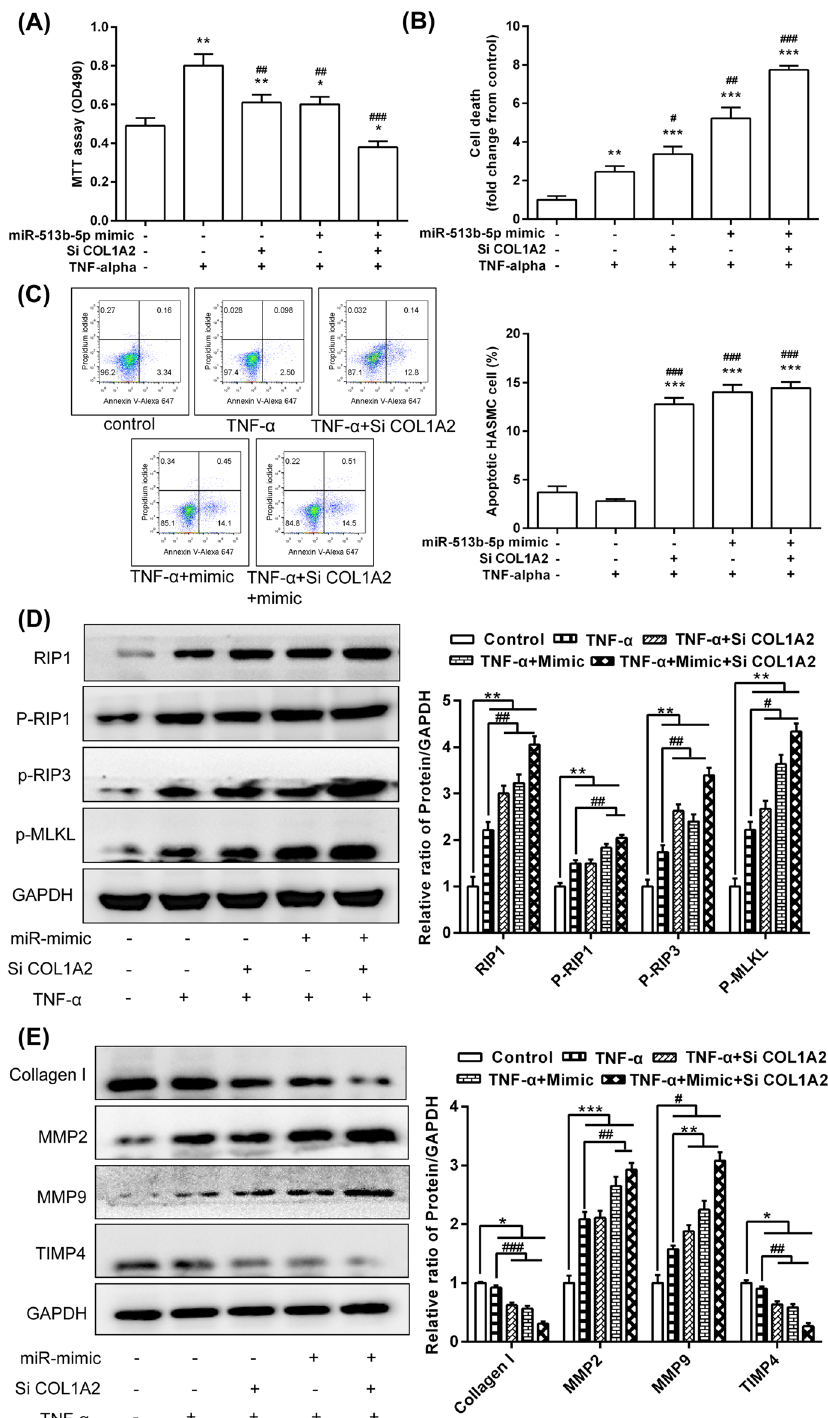
Figure 7. MiR-513b-5p/COL1A2 affected the vitality of the HASMCs during TNF-α intervention by RIP1- RIP3-MLKL and MMPs pathways. ( A ) MTT assay was used to analyse cell viability. ( B ) LDH release assay was used to detect cell death. ( C ) Flow cytometric analysis was performed to detect cell apoptosis. ( D ) Western blot was used to detect the expression of RIP1-RIP3-MLKL pathway. ( E ) The expression of related proteins in the MMP pathway. All data are expressed as means ± standard deviation, and three independent experiments were carried out. Compared with mimic NC + siRNA NC + TNF-α (−) group, * p < 0.05, ** p < 0.01, and *** p < 0.001. Compared with mimic NC + siRNA NC + TNF-α (+) group, # p < 0.05, ## p < 0.01, and ### p < 0.001. One-way ANOVA with two-sided LSD post hoc test was